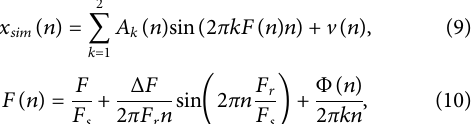
FIGURE 2 Mean estimation error ϵ OSP from simulation plotted versus model order m